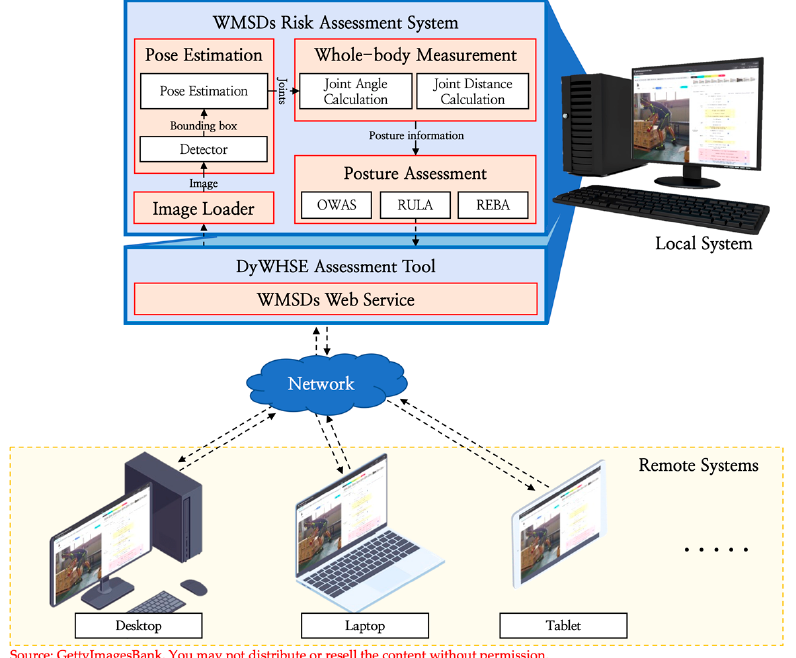
Figure 12. WMSDs risk-assessment system, which supports various computing environments.